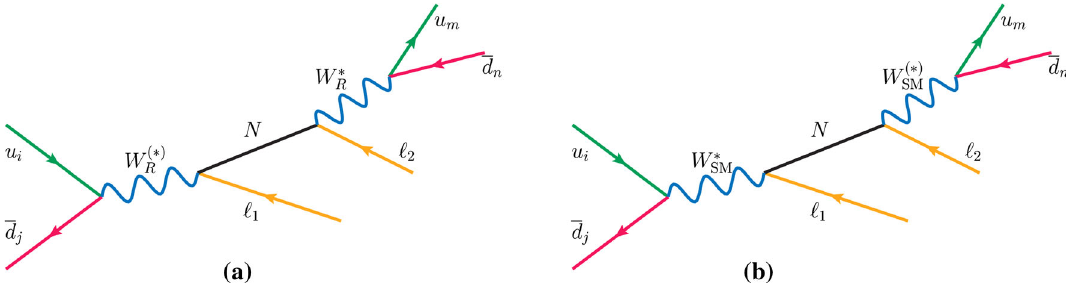
Fig. 1 Born diagrams for heavy Majorana N production and decay via a W R , b W SM currents. Drawn using JaxoDraw